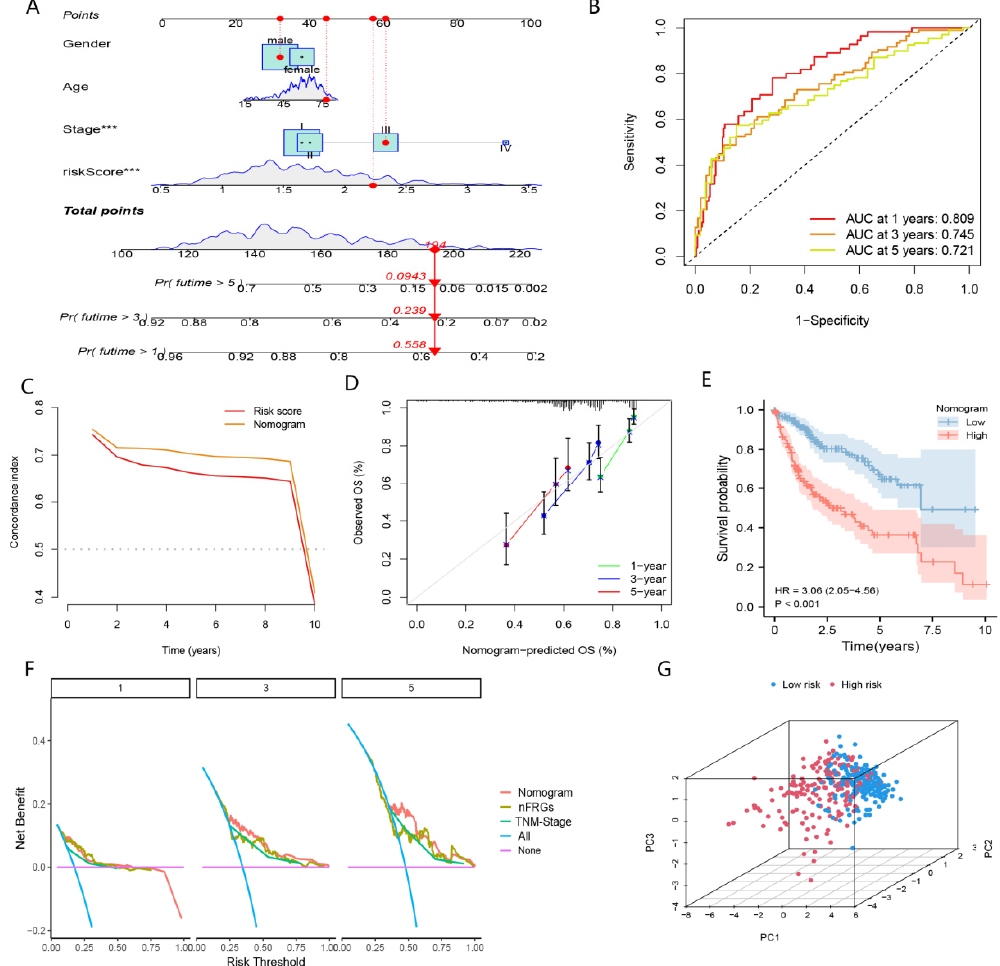
Figure 7. Nomogram based on nFRGs and other indicators. ( A ) Nomogram. ( B ) Time ROC curve of the nomogram. ( C ) C-index curve of the nomogram and risk score. ( D ) Calibration curve of the nomogram. ( E ) KM curve of nFRGs. ( F ) DCA curve of the nomogram, risk score and TNM stage. ( G ) PCA plot. (*** representing p < 0.001).